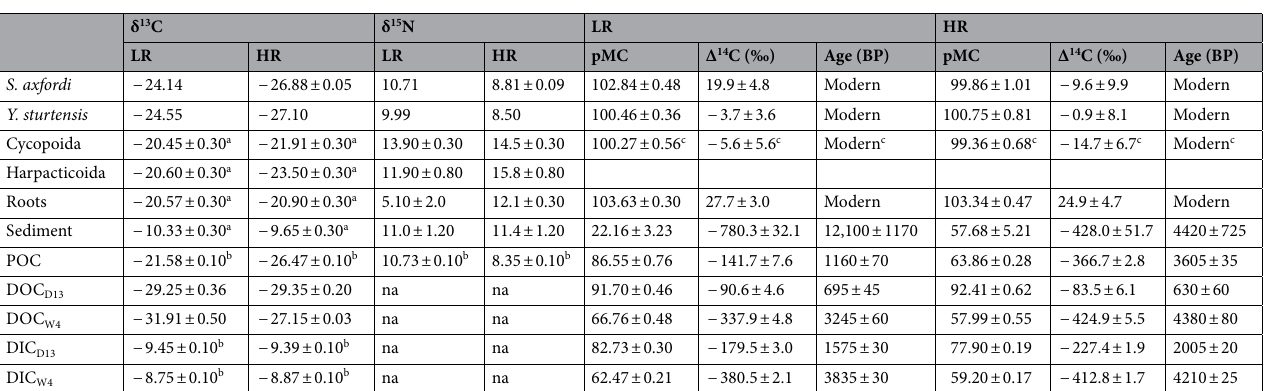
Table 1. Results from the δ 13 C, δ 15 N and 14 C analyses on Scutachiltonia axfordi (AM1), Yilgarniella sturtensis (AM2) copepods (cyclopoids and harpacticoids), sediment, roots, particulate organic carbon (POC), dissolved inorganic carbon (DIC) and dissolved organic carbon (DOC). Mean values ± standard deviations are illustrated; pMC: percent of modern carbon, with values higher than 100% generated as a result of the the Bomb Peak calibration process; BP: before present (with present as 1950). a Accuracy of the